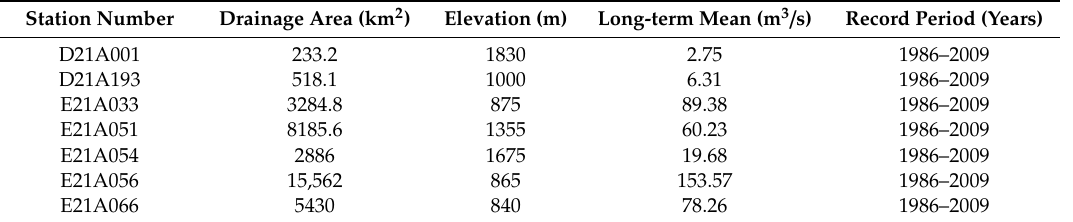
Table 2. Characteristics of streamflow gauging stations in the Upper Euphrates Basin.